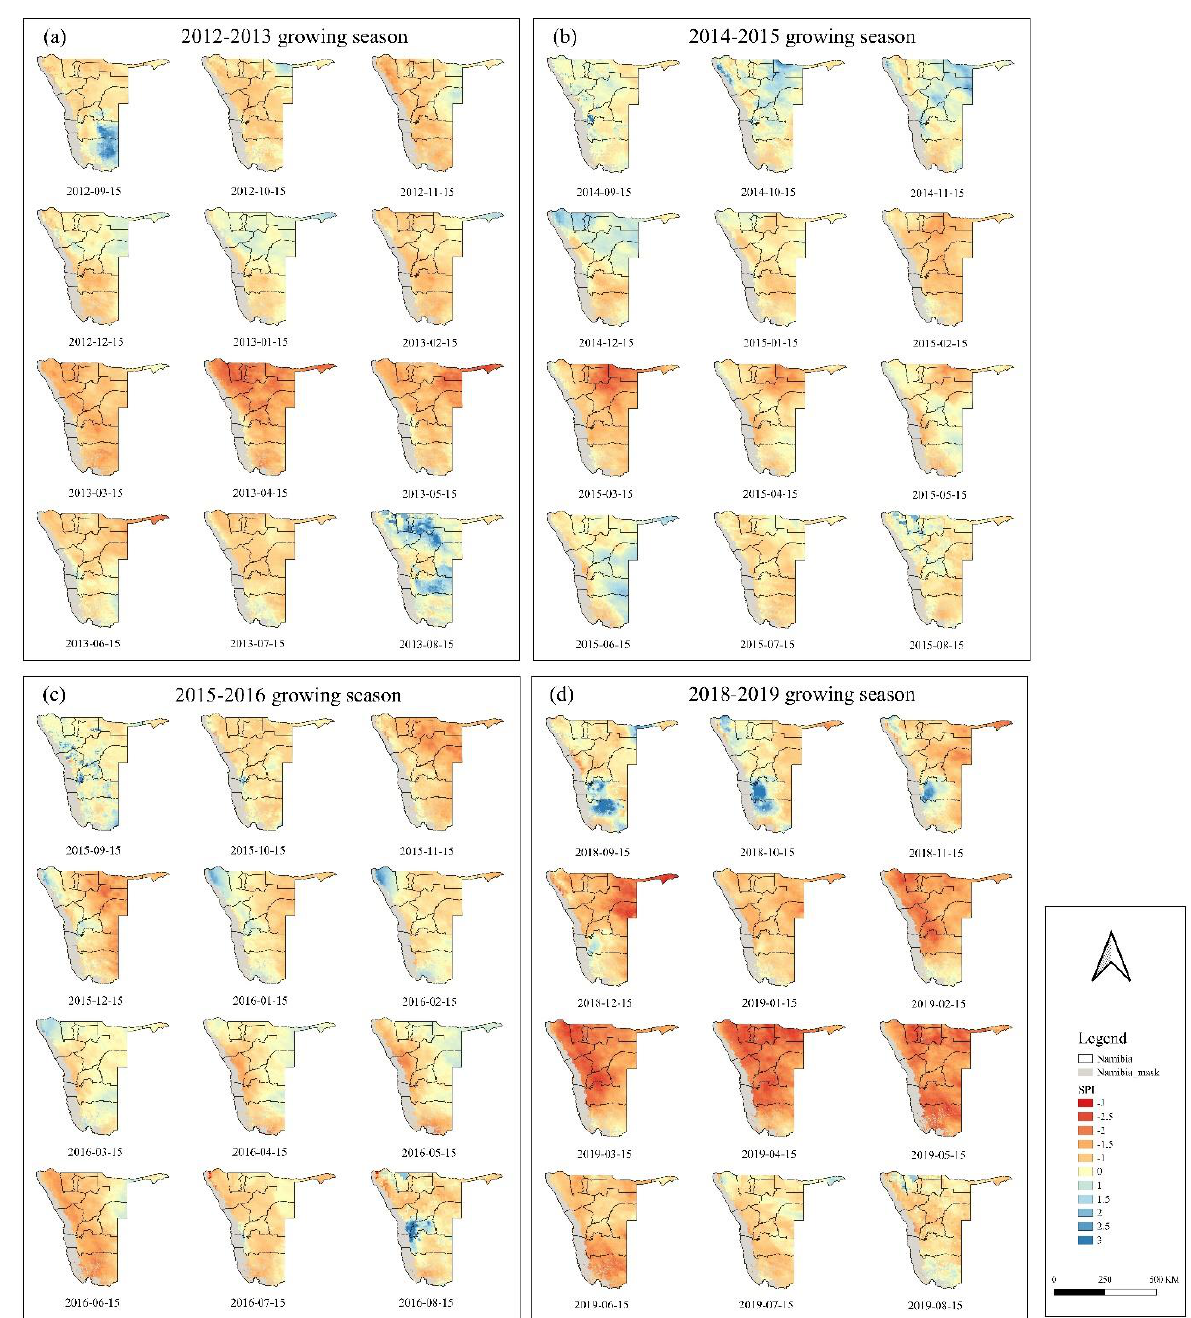
Figure 5. Spatiotemporal dynamics of SPI (three-month): ( a ) SPI in the 2012–2013 growing season; ( b ) SPI in the 2014–2015 growing season; ( c ) SPI in the 2015–2016 growing season; ( d ) SPI in the 2018–2019 growing season.